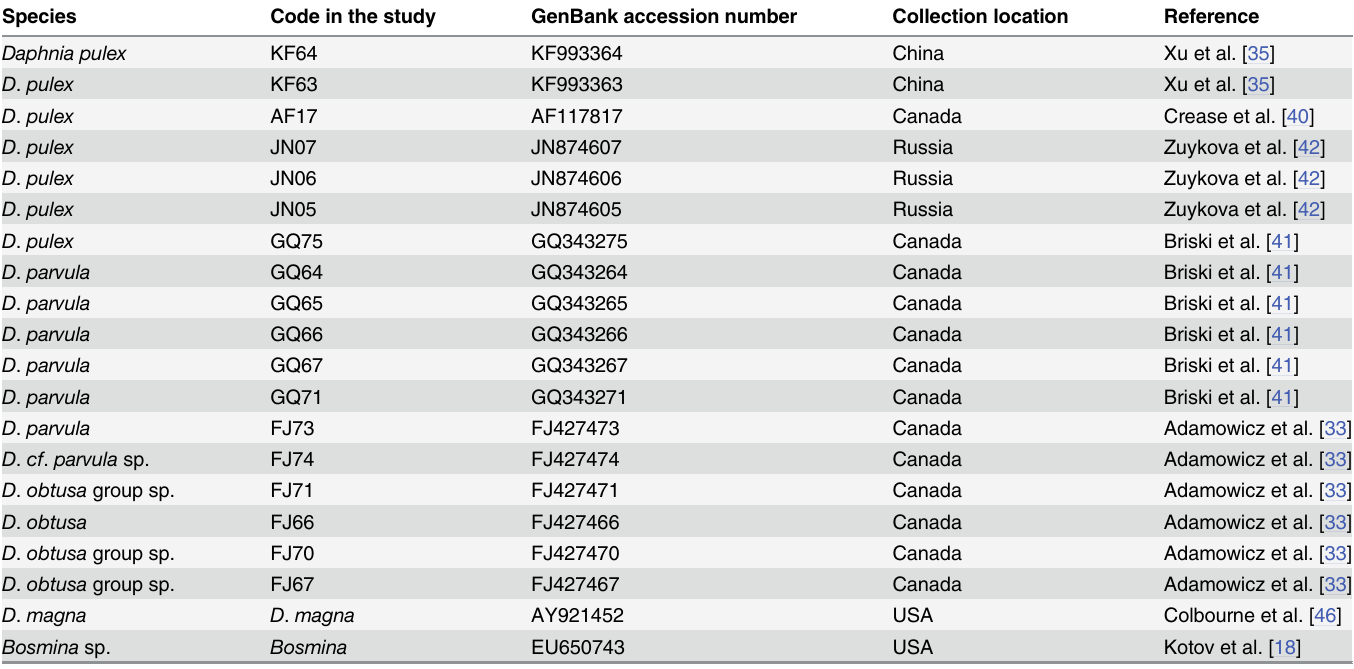
Table 2. 16S rDNA sequences of Daphnia and Bosmina from GenBank.